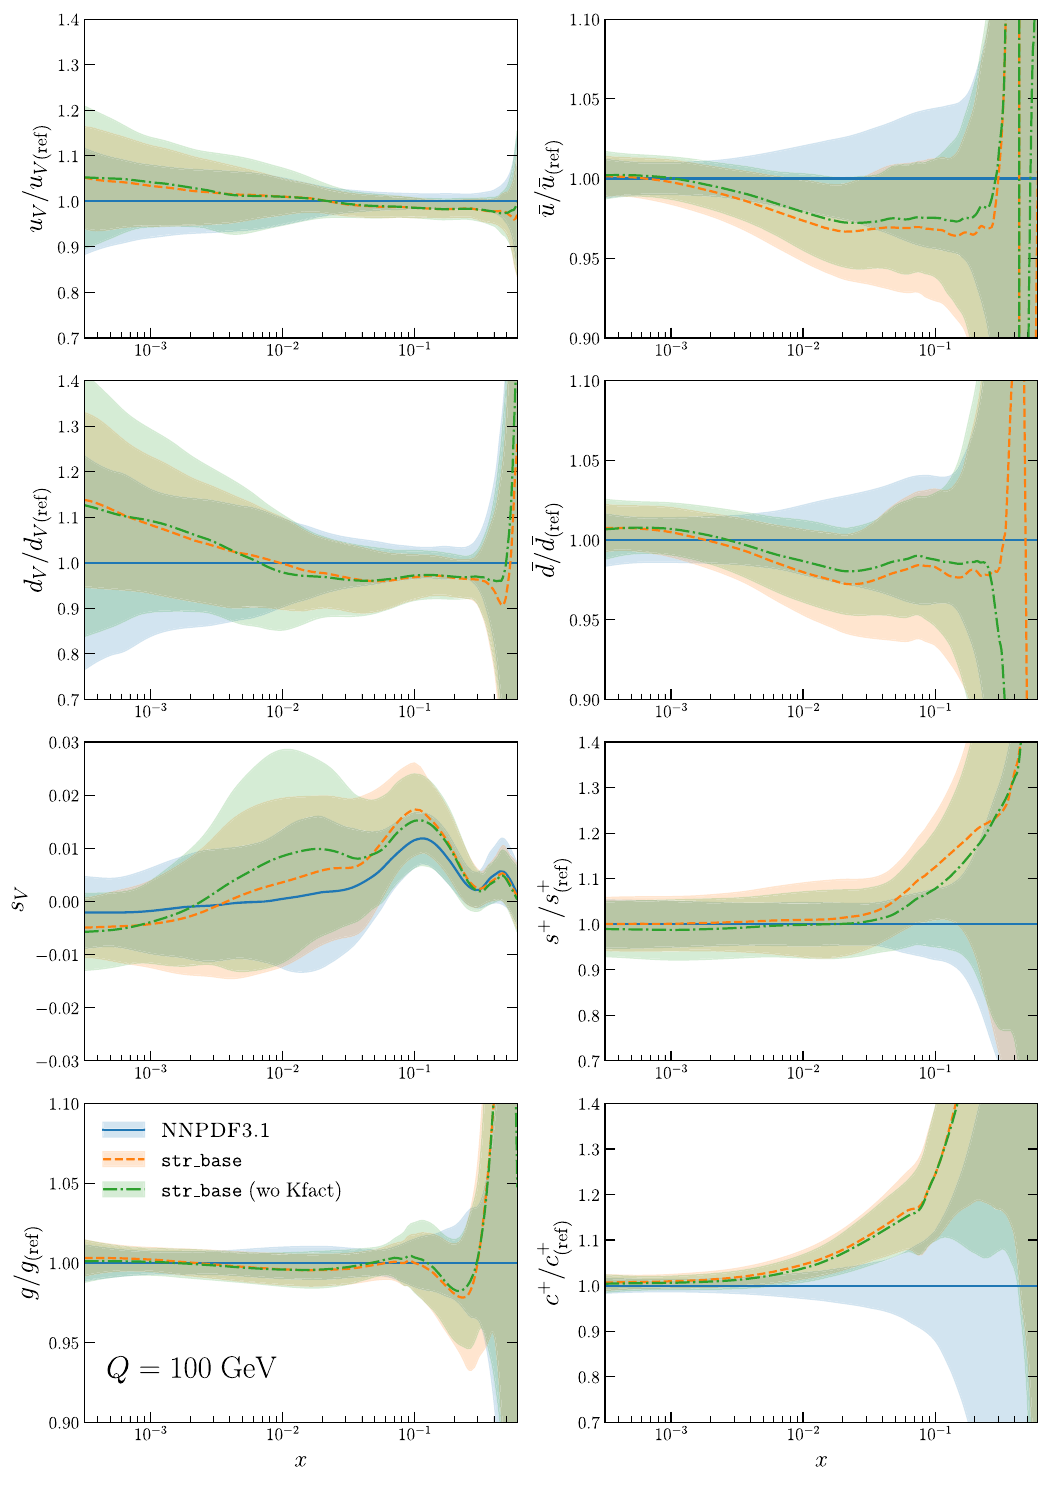
Fig. 5 Comparison between the NNPDF3.1 NNLO fit [19] and the baseline fit used in this work, str_base . From top to bottom and left to right we show the up (valence and sea), down (valence and sea), strange (valence and total), gluon, and charm distributions at a